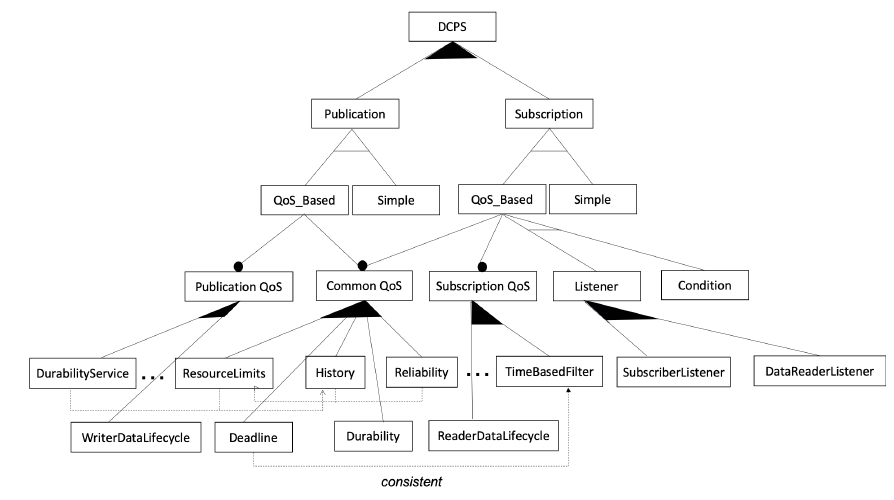
Figure 2. Feature model of